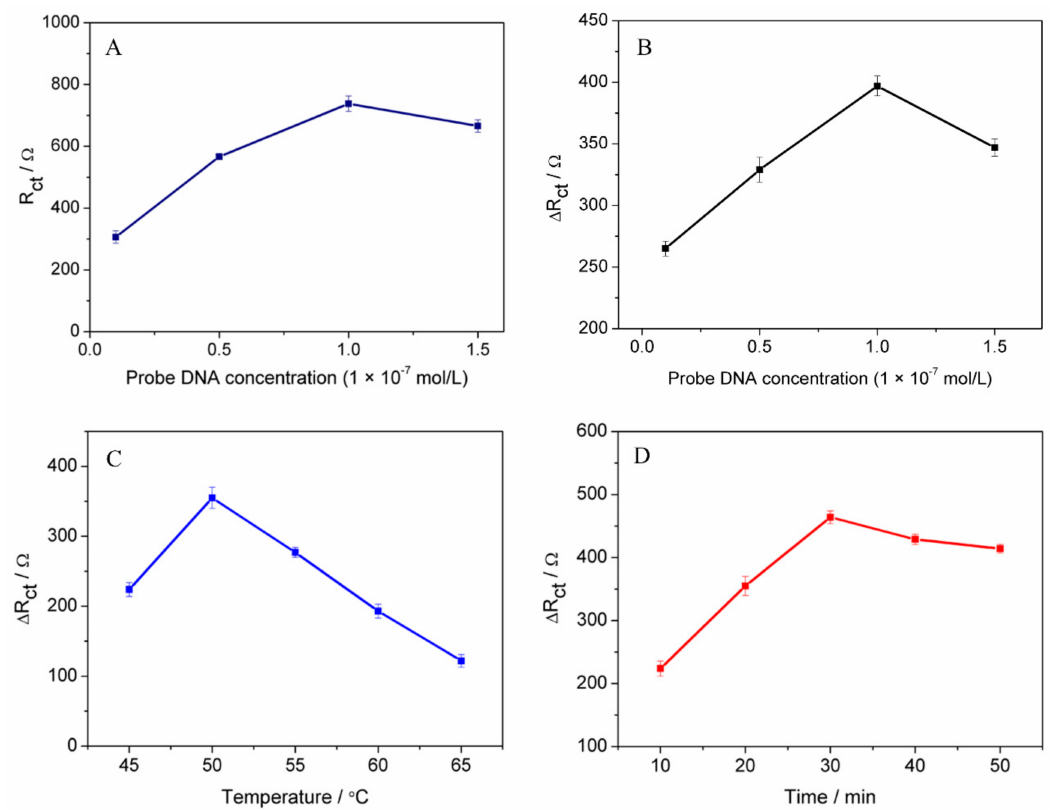
Figure 4. ( A ) Influence of different concentratiosn of ssDNA probe at the CeO 2 /CHIT/GCE; ( B ) the comparison of different concentratiosn of ssDNA probe hybridized with 1 × 10 − 7 tDNA; ( C ) influence of different hybridization temperatures; and ( D ) influence of different hybridization periods at 50 ◦ C. The error bars represent the standard deviation of three